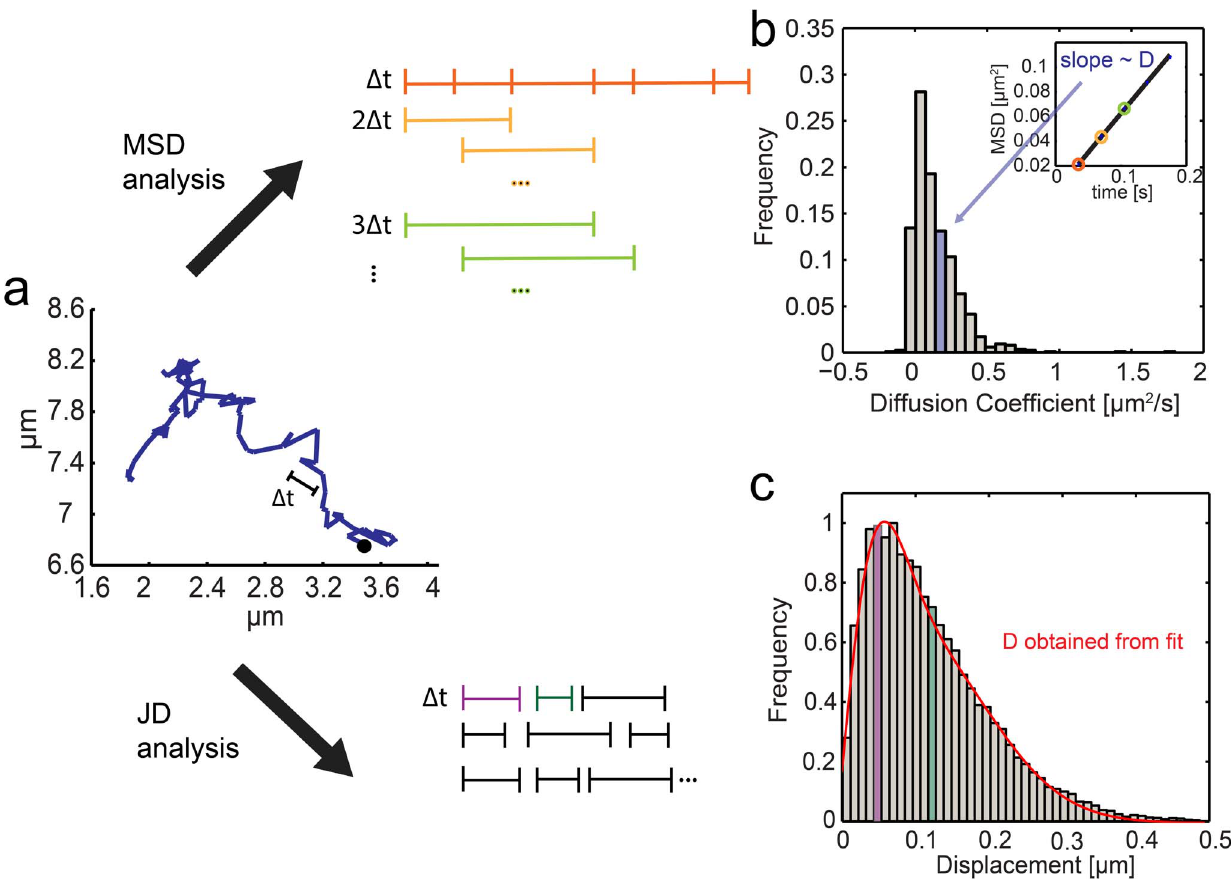
Figure 1. Principle of the mean-square displacement (MSD) and jump distance (JD) analyses. (a) A typical single trajectory of receptor- bound LPS recorded in live macrophages ( D t =33 ms). Trajectory data can be analyzed either by MSD or JD analysis. For MSD analysis, an average of the mean-square displacement is calculated over all points of the individual trajectory for multiples of the smallest resolved time intervals ( D t , 2 D t, 3 D t etc). The MSD plot over n D t is linear and the gradient is directly proportional to the diffusion coefficient. (b) Diffusion coefficients are obtained for all single trajectories and typically presented in histograms. For a random walk with a single diffusion coefficient and long trajectories this distribution is centered around the diffusion coefficient. Multiple mobility populations can be resolved in principle, however a reliable dissection requires a fairly large data set (Note S3 in File S1). The JD analysis plots a histogram of all particle displacements within a fixed time interval D t for all trajectories. (c) Fitting Eq. 7 to the distribution of the displacements yields the minimum number of diffusion coefficients needed to describe the motion of the particles in the system.